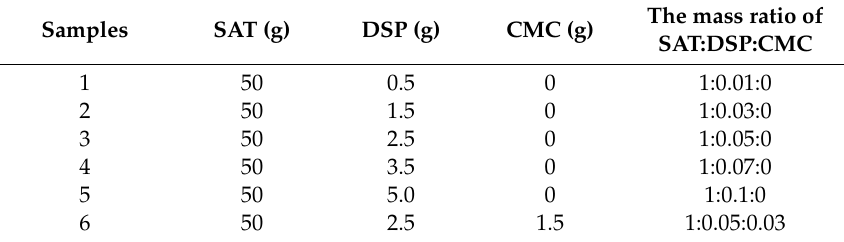
Table 1. Samples composition of SAT / DSP /